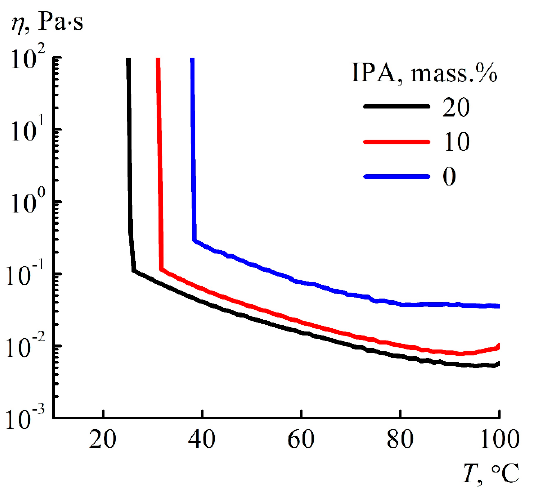
Figure 4. Temperature dependence of the viscosity of NMMO monohydrate with different alcohol content.